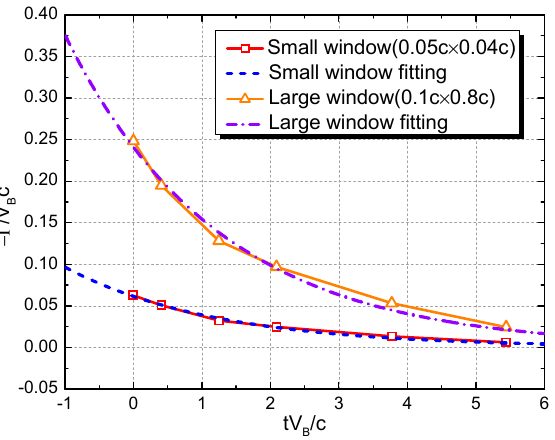
Figure 18. Integral windows of vortex circulation with fixed windows.